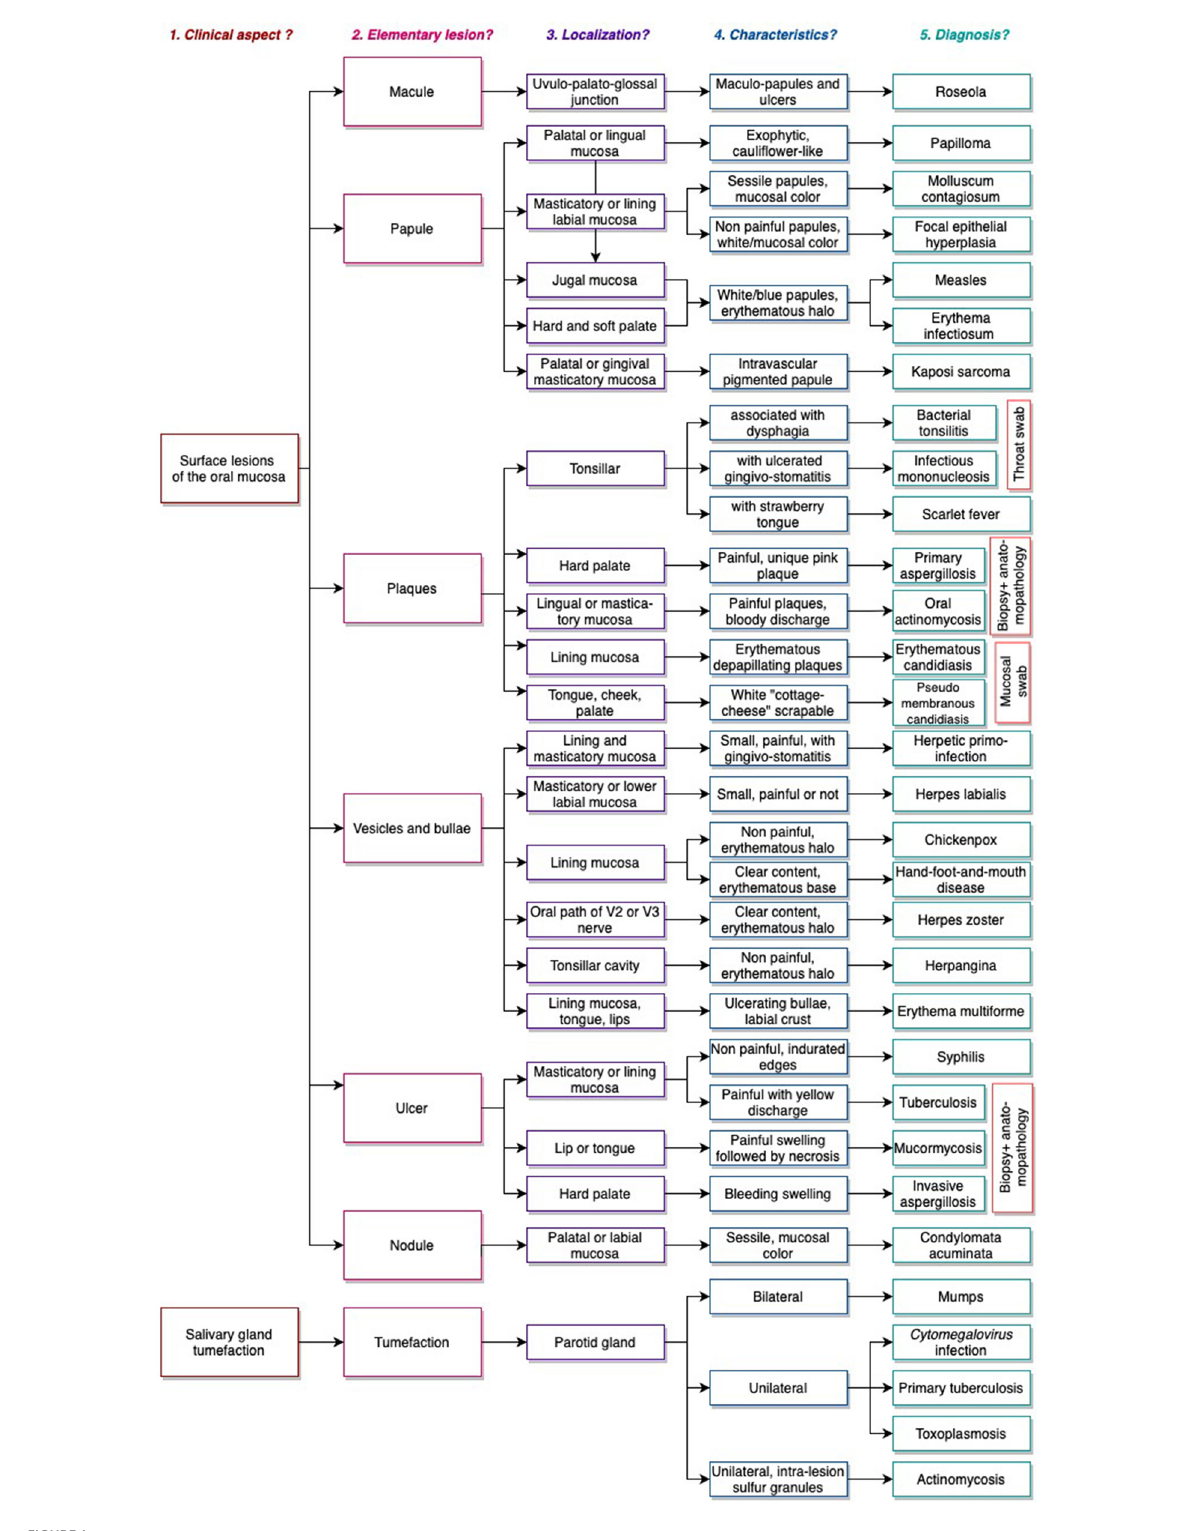
FIGURE1 Decision